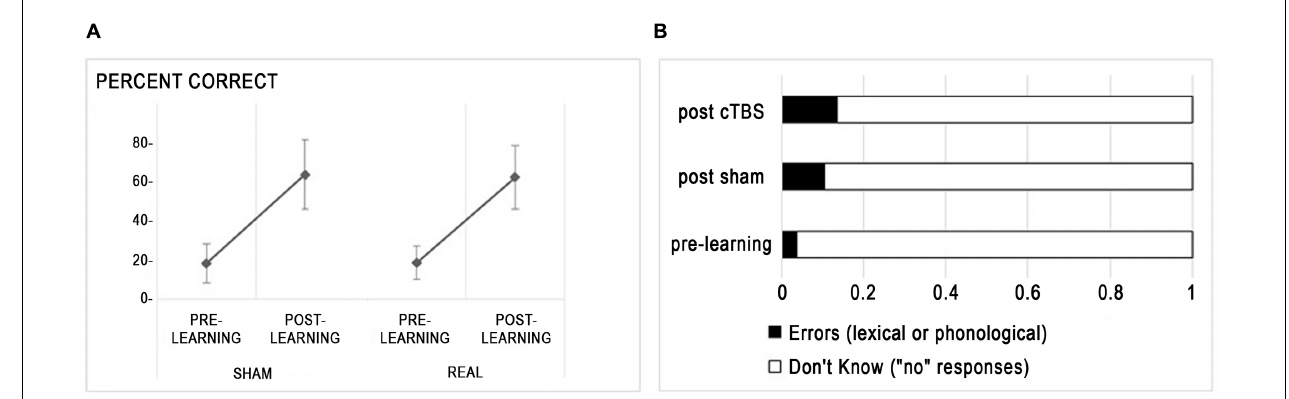
FIGURE 2 | Behavioral effects of rTMS. (A) Percent correct responses (mean ± standard deviation) are displayed for each stimulation condition. (B) Distribution of incorrect responses before and after learning.